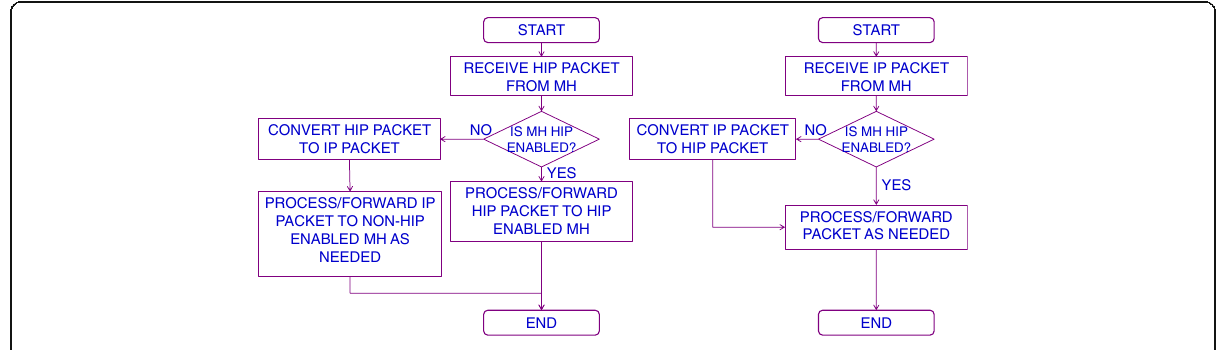
Fig. 5 HIP SA for data processing, encapsulation, and